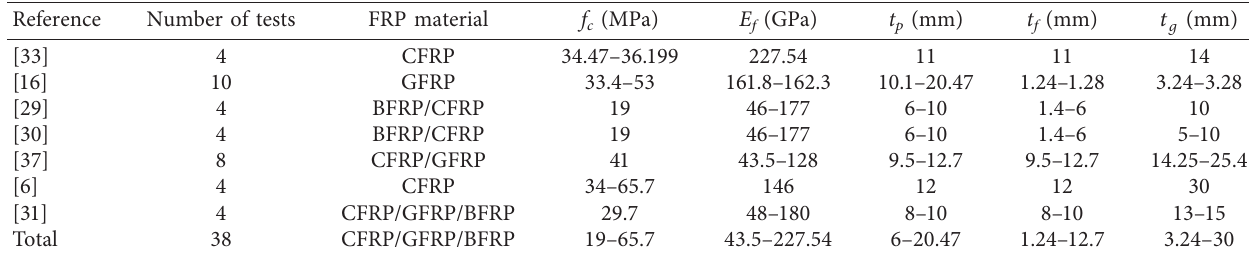
Table 5: Database under the concrete crush or FRP rupture failure mode.